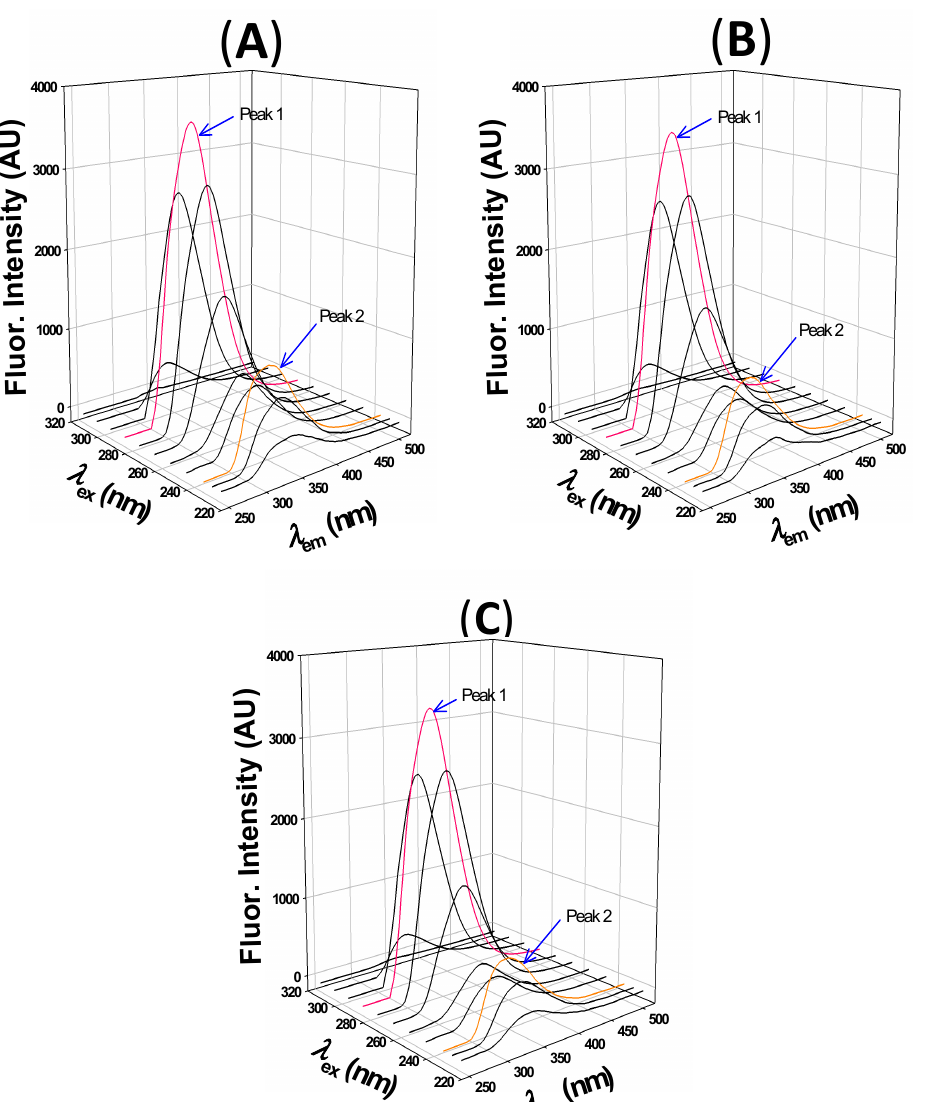
Figure 6. 3D fluorescence spectra of HSA at different HSA to 2,4-TZD molar ratios. ( A ) HSA only, ( B ) molar ratio 1:5, and ( C ) molar ratio 1:10.